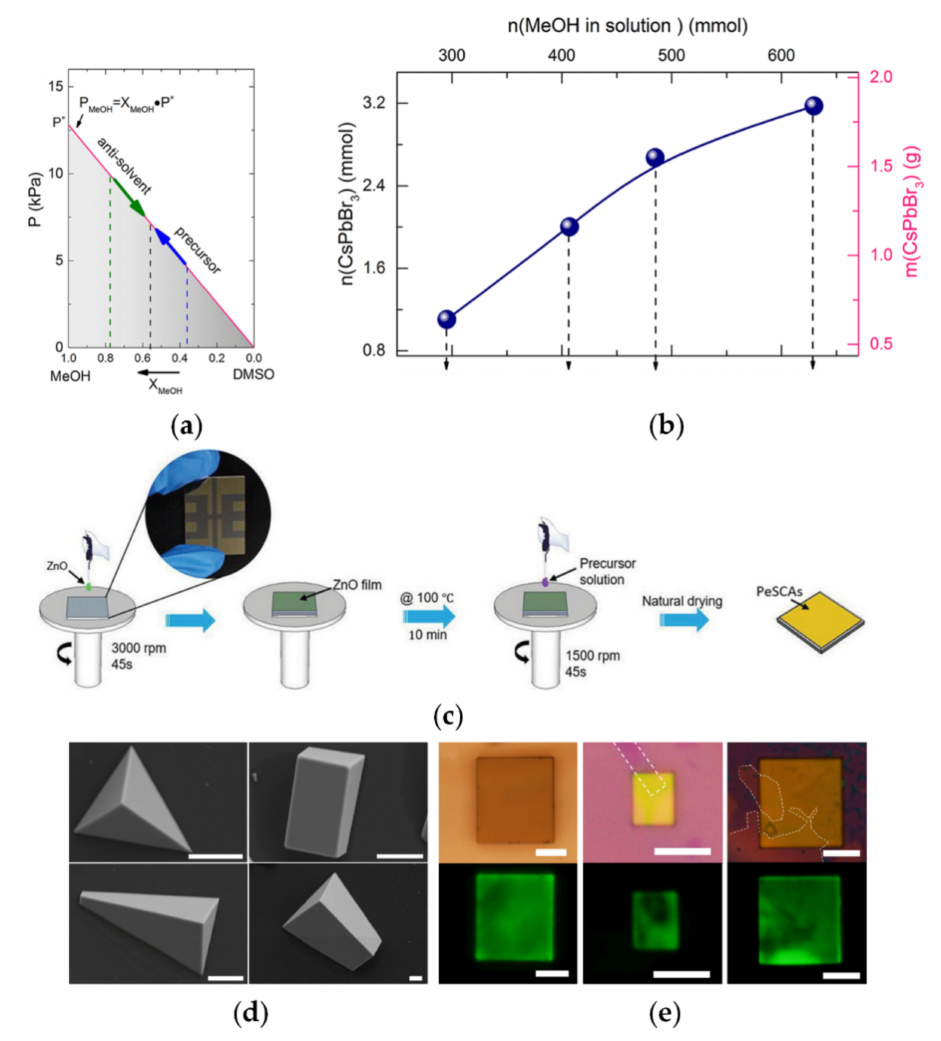
Figure 3. ( a ) The calculation result of vapor pressure using Raoult’s law Adapted with permission from Ref. [54]. 2017, American Chemical Society; ( b ) relationship between the obtained mass of CsPbBr 3 and the amount of MeOH in solution. Adapted with permission from Ref. [54]. 2017, American Chemical Society; ( c ) schematic of the preparation of PeSCAs, with the inset showing the substrates used in the experiments Adapted with permission from Ref. [69]. 2020, John Wiley and Sons; ( d ) SEM images of CVD-synthesized CsPbX 3 PSCs Adapted with permission from Ref. [70]. 2016, Springer Nature.; ( e ) emissions of CsPbX 3 PSCs under UV excitation Adapted with permission from Ref. [70]. 2016, Springer